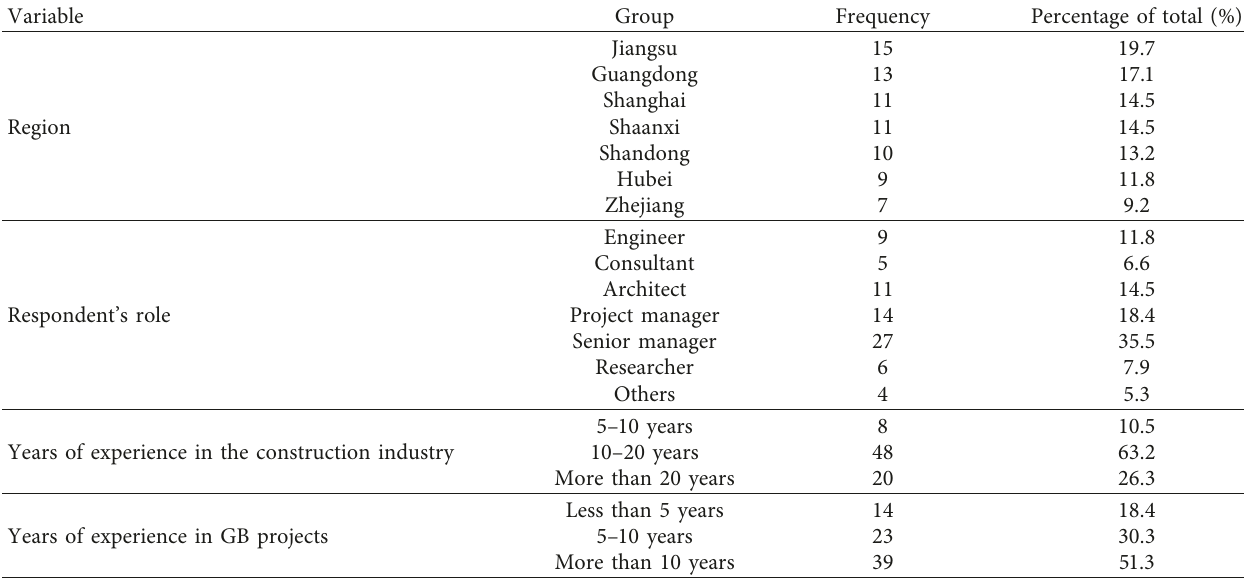
Table 2: Profile of